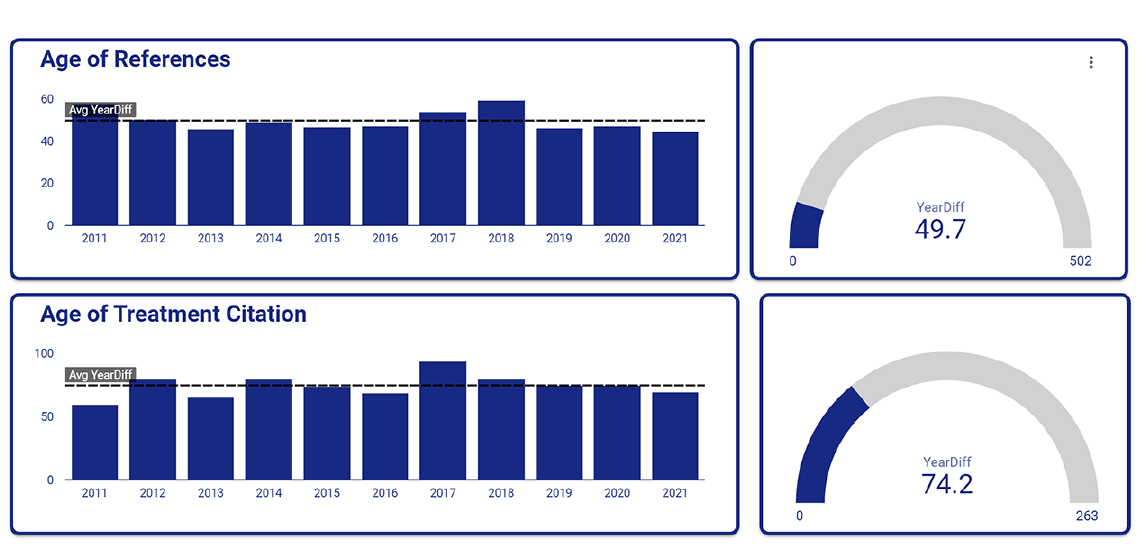
Fig. 4. Age of Reference: The average difference of the publication year of an article with those of the publications included in the bibliographic references. Age of Treatment Citations: The average difference between the year of publication of a taxonomic treatment and the cited treatments. New species generally do not include treatment citations. The biggest difference is when a treatment includes the citation of the original treatments by Linnaeus, 1753 for plants or 1758 for